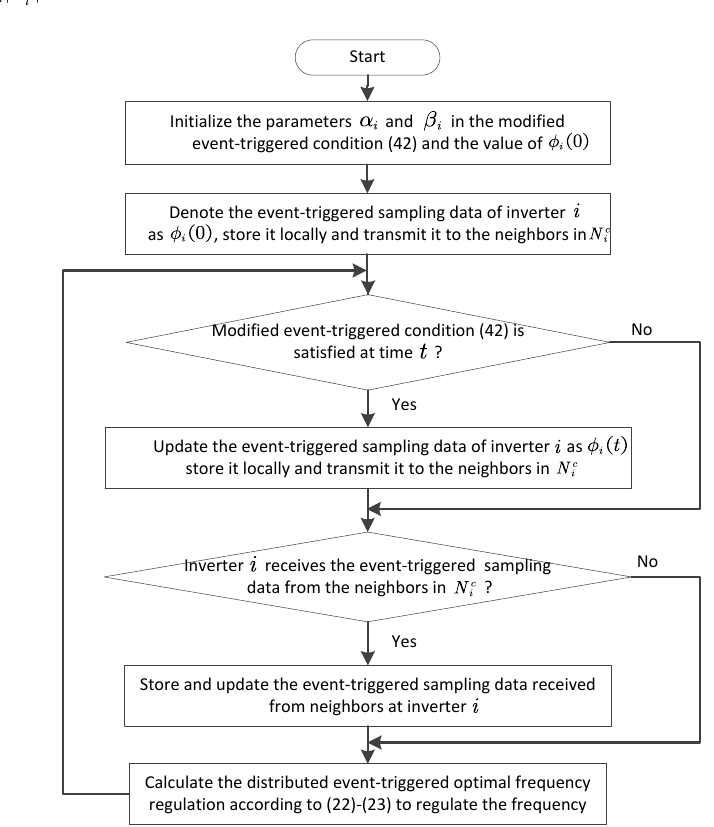
Figure 2. The flowchart of distributed optimal frequency regulation algorithm (22) and (23) with modified event-triggered condition